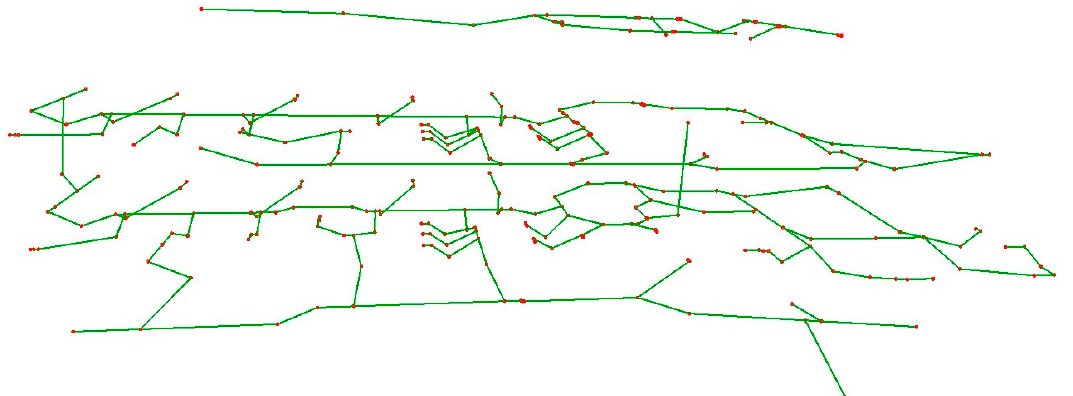
Figure 9. Navigation network derived from the IFC dataset using the first method.